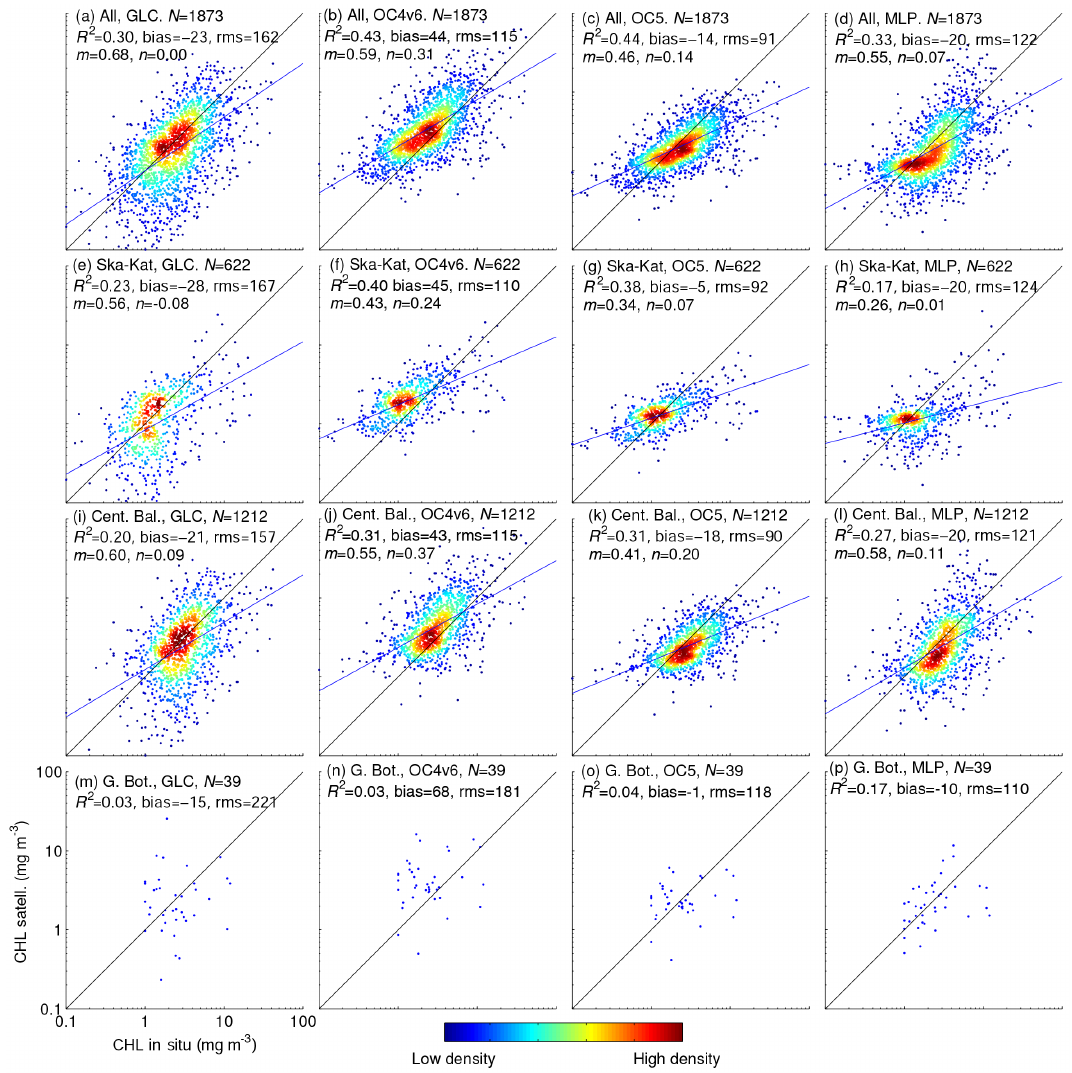
Figure 2. Density scatter plots of in situ vs. satellite-retrieved Chl a for all algorithms providing meaningful values. The line of best fit (blue) and that of equal value (black) are superimposed, with relevant